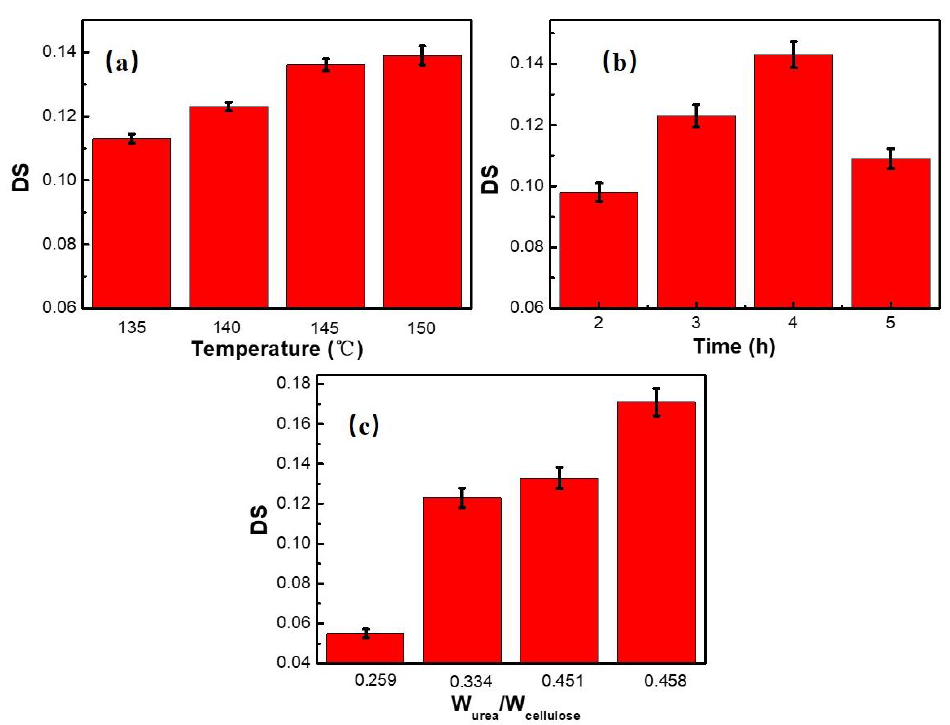
Figure 1. Relationship between the CC degree of substitution and carbamate reaction conditions: temperature (time: 3 h and W urea /W cellulose : 0.334) ( a ), time (temperature: 140 °C and W urea/ W cellulose : 0.334) ( b ), and weight ratio of urea/cellulose (time: 3 h and temperature: 140 °C) ( c ).